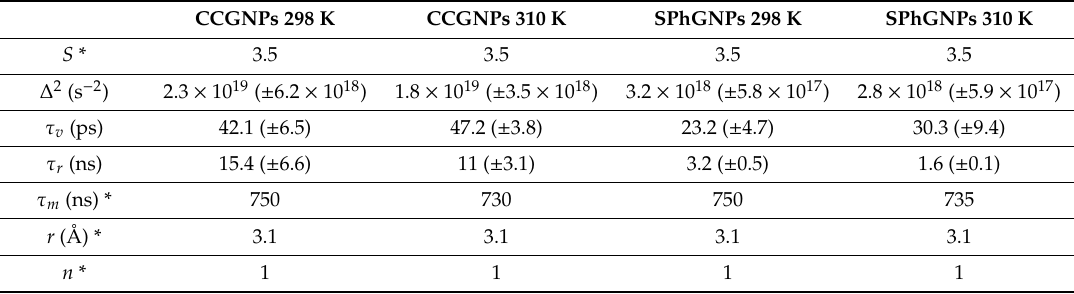
Table 2. NMRD best fit parameters for PEG-Gd@CCGNPs and PEG-Gd@SPhGNPs at 298 K and 310